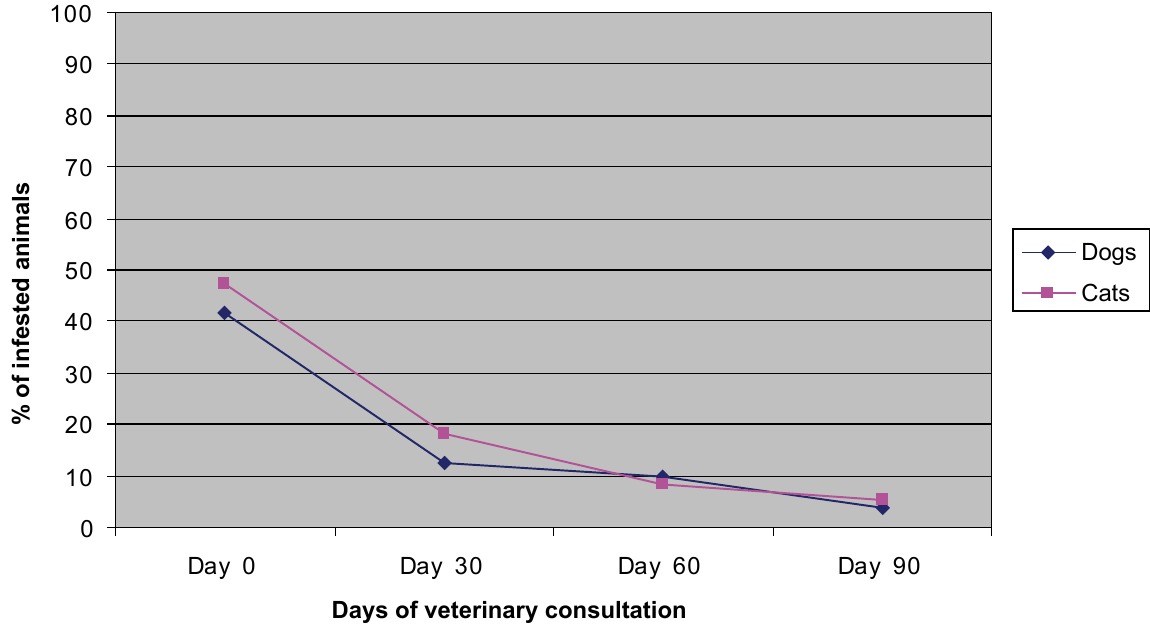
Fig 1. – Evolution of the rate of flea infestation during the three month